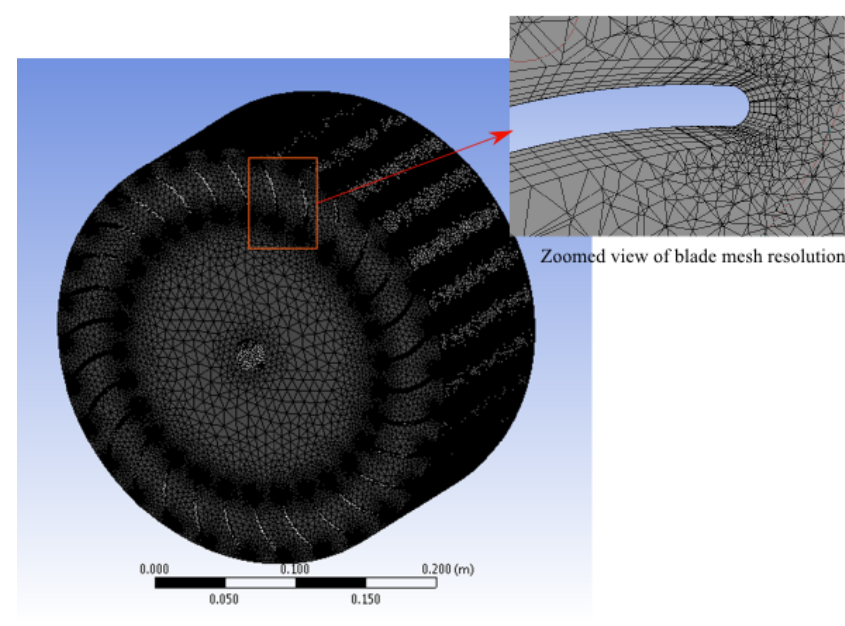
Figure 5. A typical computational mesh of the